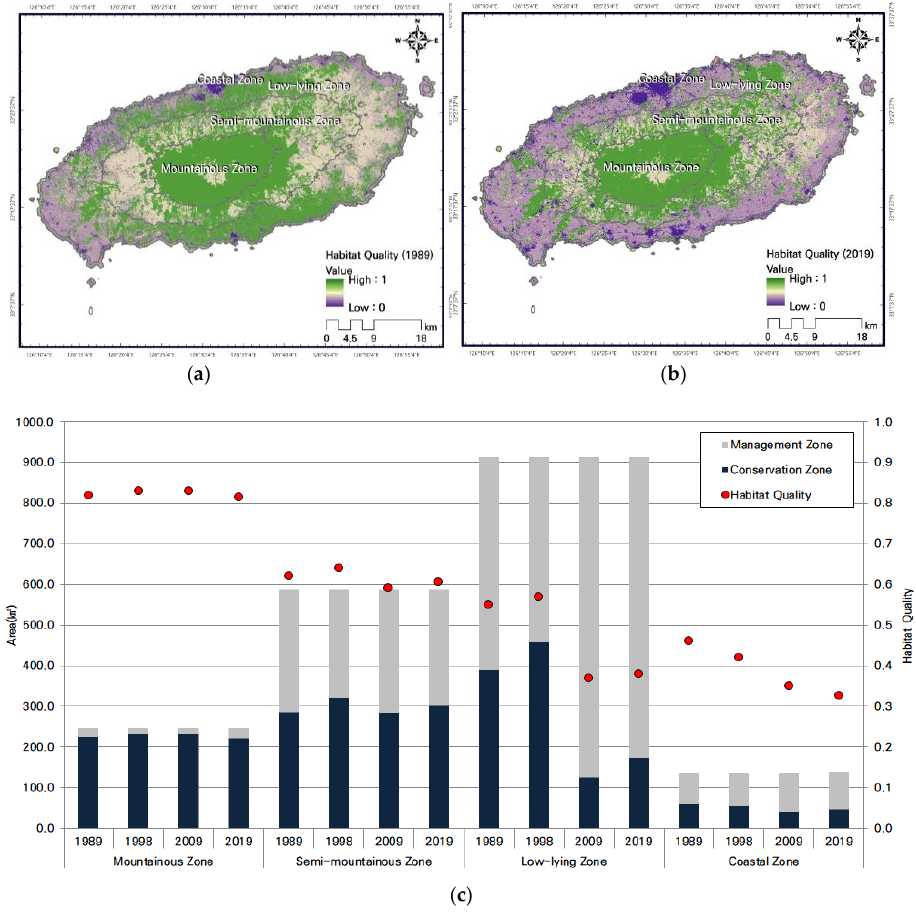
Figure 3. Changes in habitat quality on Jeju, South Korea. ( a ) Distribution of habitat quality in 1989. ( b ) Distribution of habitat quality in 2019. ( c ) Changes in habitat quality.